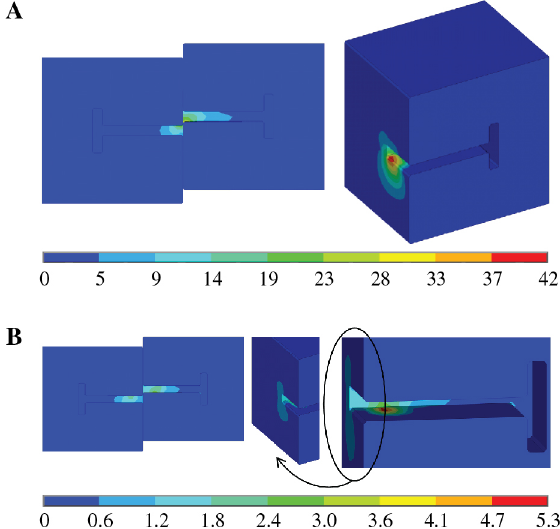
Figure 9: The distribution of equivalent von Mises stress in the two epistyles for (A) the CF- and (B) the RS-type of speci-